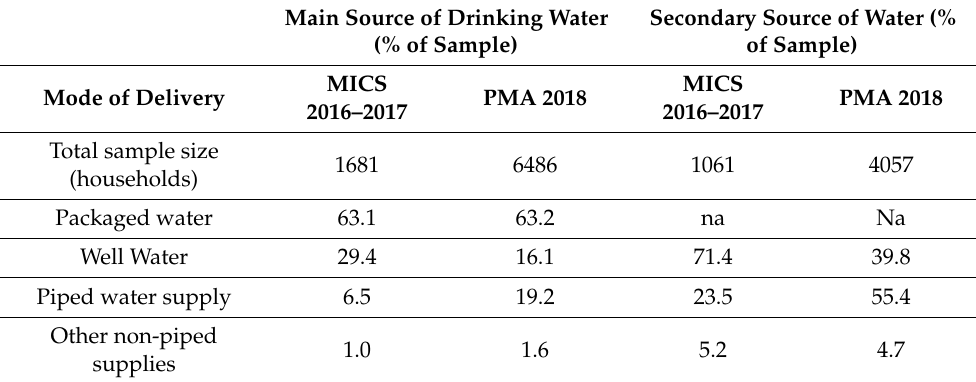
Table 1. Mode of delivery for drinking water supplies in Lagos